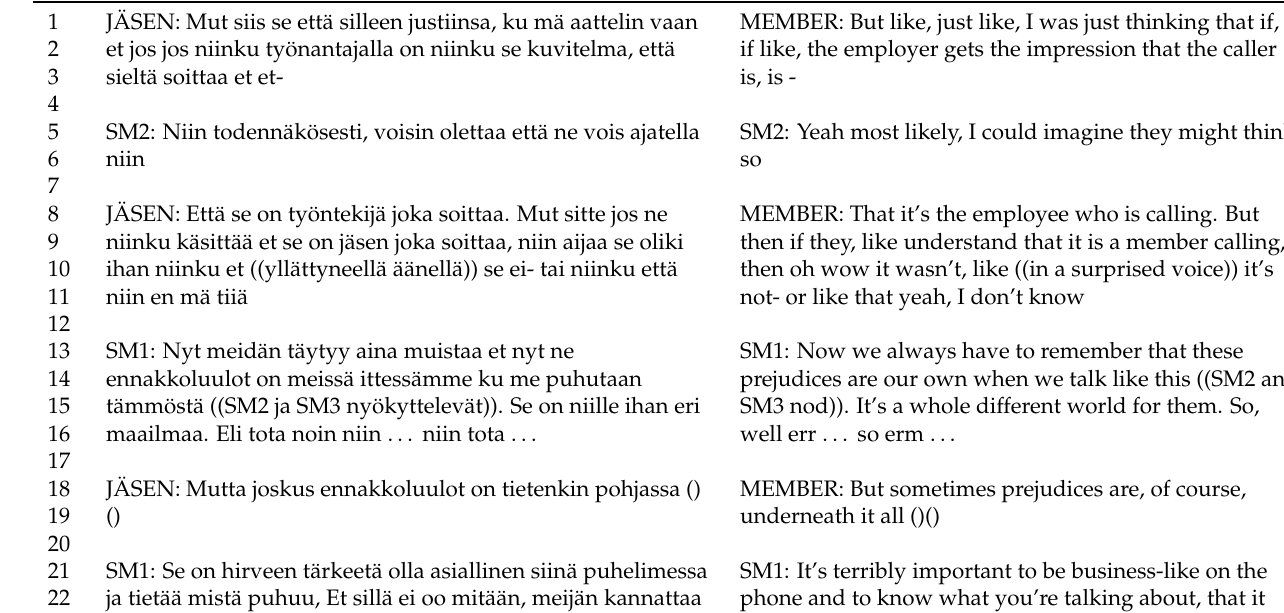
Table 6. Excerpt 2c